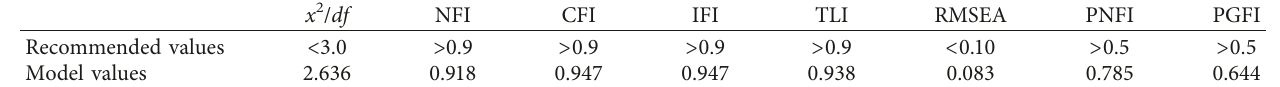
Table 10: Goodness-of-fit indices.